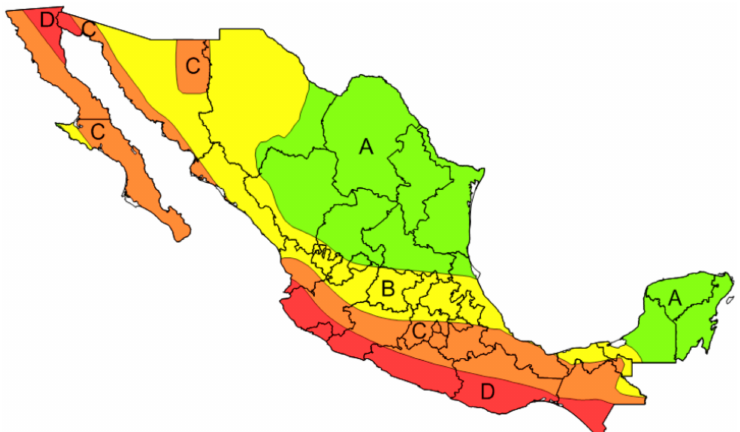
Figure 2. Seismic hazard zones classification in Mexico, reproduced with permission from Ulises Mena, Comisi ó n Federal de Electricidad Manual de Diseño de Obras Civiles; published by Comision Federal de Electricidad (CFE), 2015